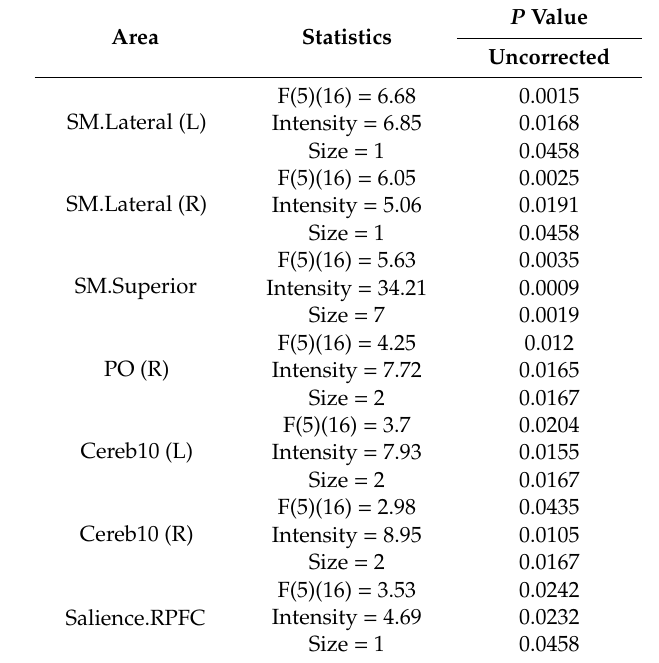
Table 4. Mouth < Nose contrast connected regions included ROI that were more significantly connected at a 0.05 one-sided (positive) uncorrected- P